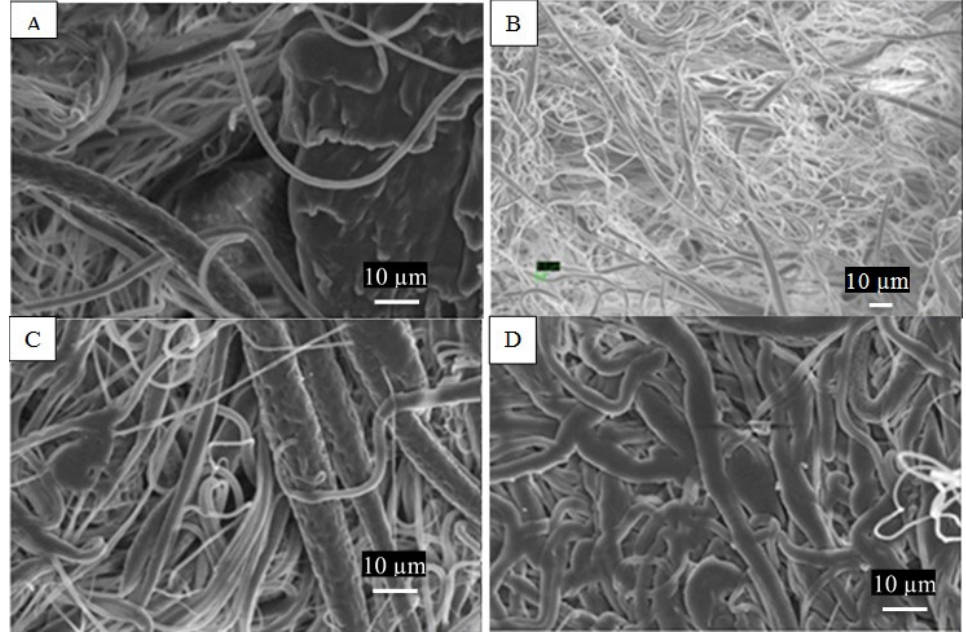
Figure 4. SEM images of PCL fibers prepared from 12.5 wt% PCL in THF solvent only, at different rotational speeds. ( A ) 5000 rpm; ( B ) 6000 rpm; ( C ) 7000 rpm; ( D ) 8000 rpm.